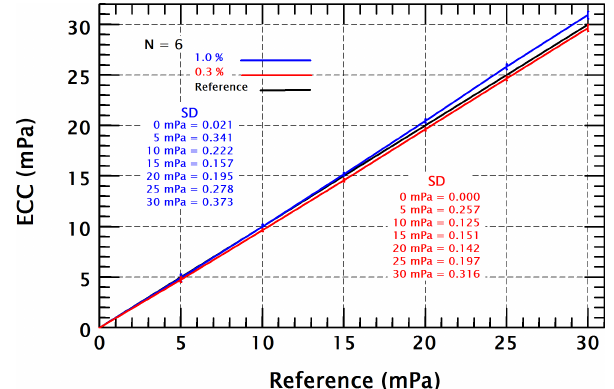
Figure 5. Digital calibration bench results between the (1.0%, 1.0B) solution, blue curve, and the (0.3%, 0.3B) solution, red curve; the reference curve is shown in black.